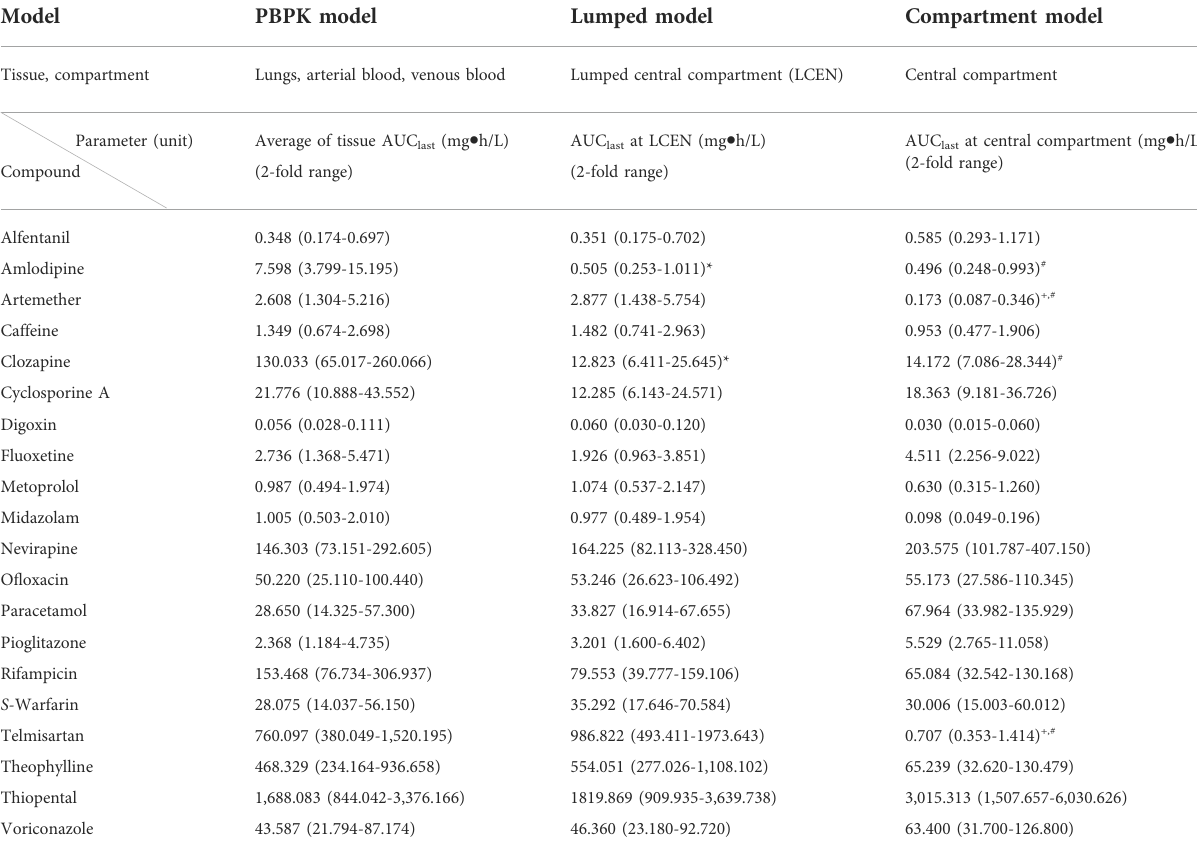
TABLE 1 Comparison of AUC parameters of central compartment in PBPK, lumped, and compartment models for 20